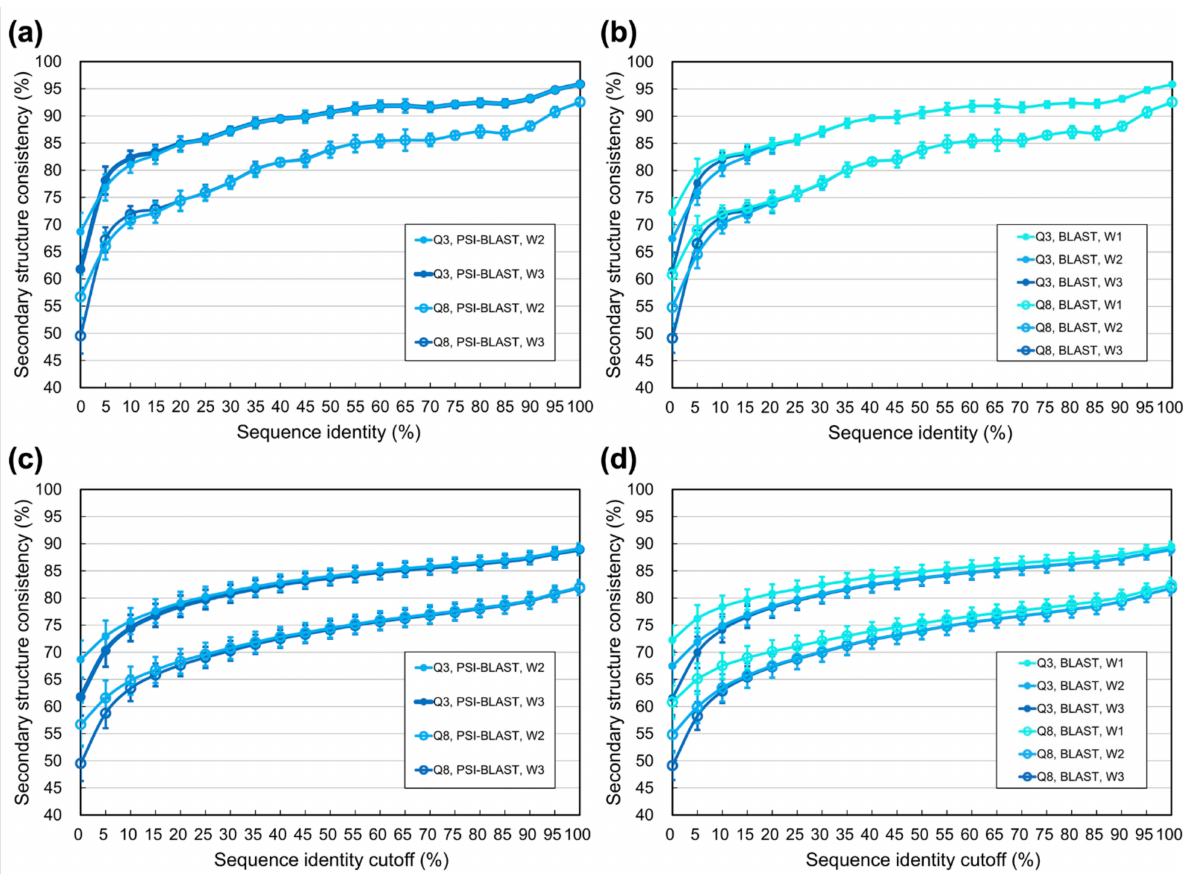
Figure 9. Secondary structural consistency measured by PSI-BLAST and BLAST with different word sizes. ( a )